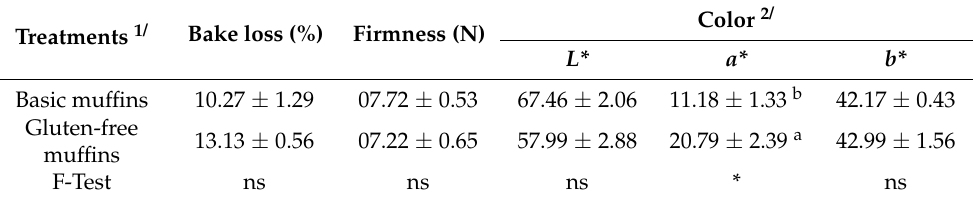
Figure 4. Characteristics of muffins. Muffins using wheat flour ( A , C ) and muffins using cassava flour ( B , D ). Table 4. Color values and physical characteristics of gluten-free muffins from cassava flour.